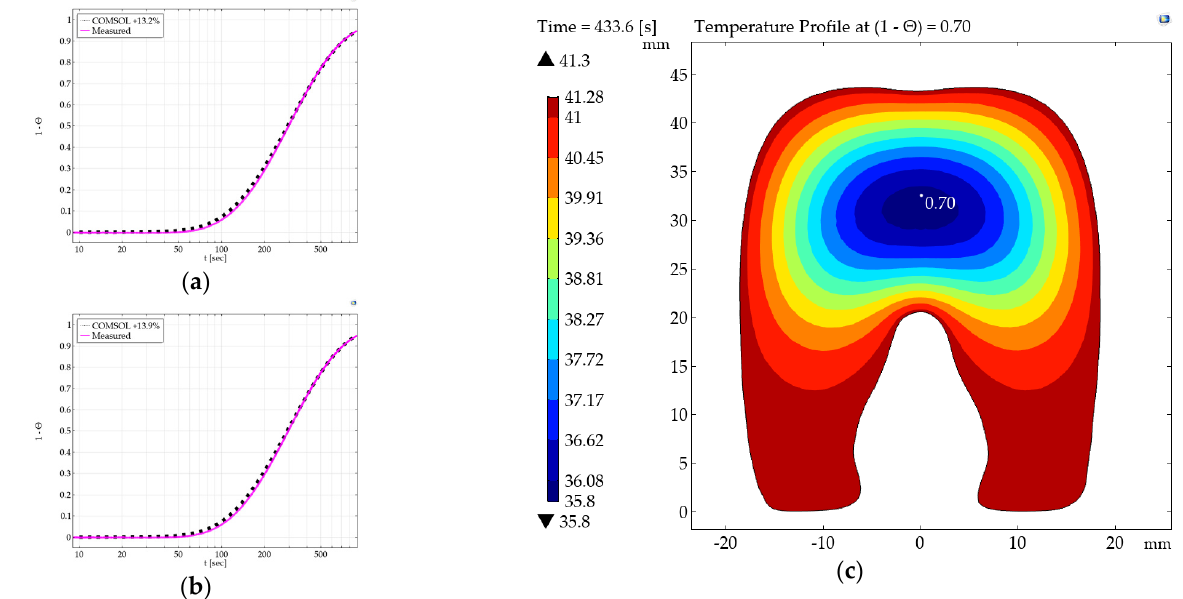
Figure 12. Two (E1_#4 ( a ), E1_#5 ( b )) measurement results of elephant plotted against fitted 3D simulation output for thermal diffusivity and a widthwise cross section of E1_#4 ( c ) [12].